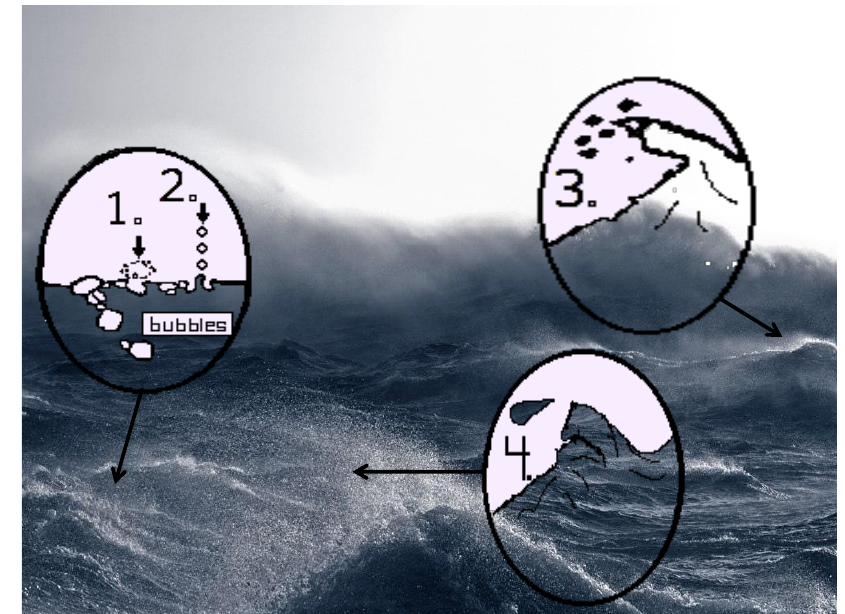
Fig. 1. Sea-spray aerosol generating mechanisms. 1. The smallest particles, typically with particle diameters less than 1µm, are film droplets. They are produced from bubble bursting, and the filaments of the bubble are left above the water surface. 2. Somewhat larger particles are produced by the jet following the void left at the ocean surface by the bubble. These jet drops have a typical radius of 1–10µm. 3. Larger particles still are produced as spume is torn off the wave crests, which only happens in strong winds (Monahan et al., 1986). 4. The last depicted mechanism generates splash drops, which are large particles with such short lifetimes that they only participate in SSA production as a source of the other